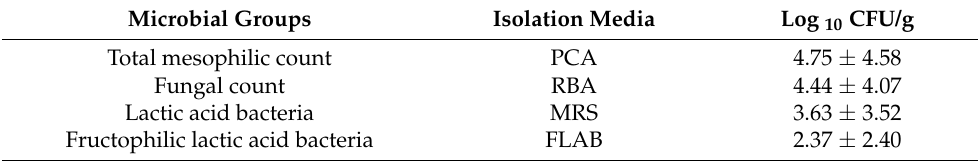
Table 1. Culturable bacterial and fungal populations on the surface of “Bisucciu” apricot fruits. Microbial Groups Isolation Media Log 10 CFU/g Total mesophilic count PCA Fungal count RBA 4.44 ± 4.07 Lactic acid bacteria MRS 3.63 ± 3.52 Fructophilic lactic acid bacteria FLAB 2.37 ± 2.40